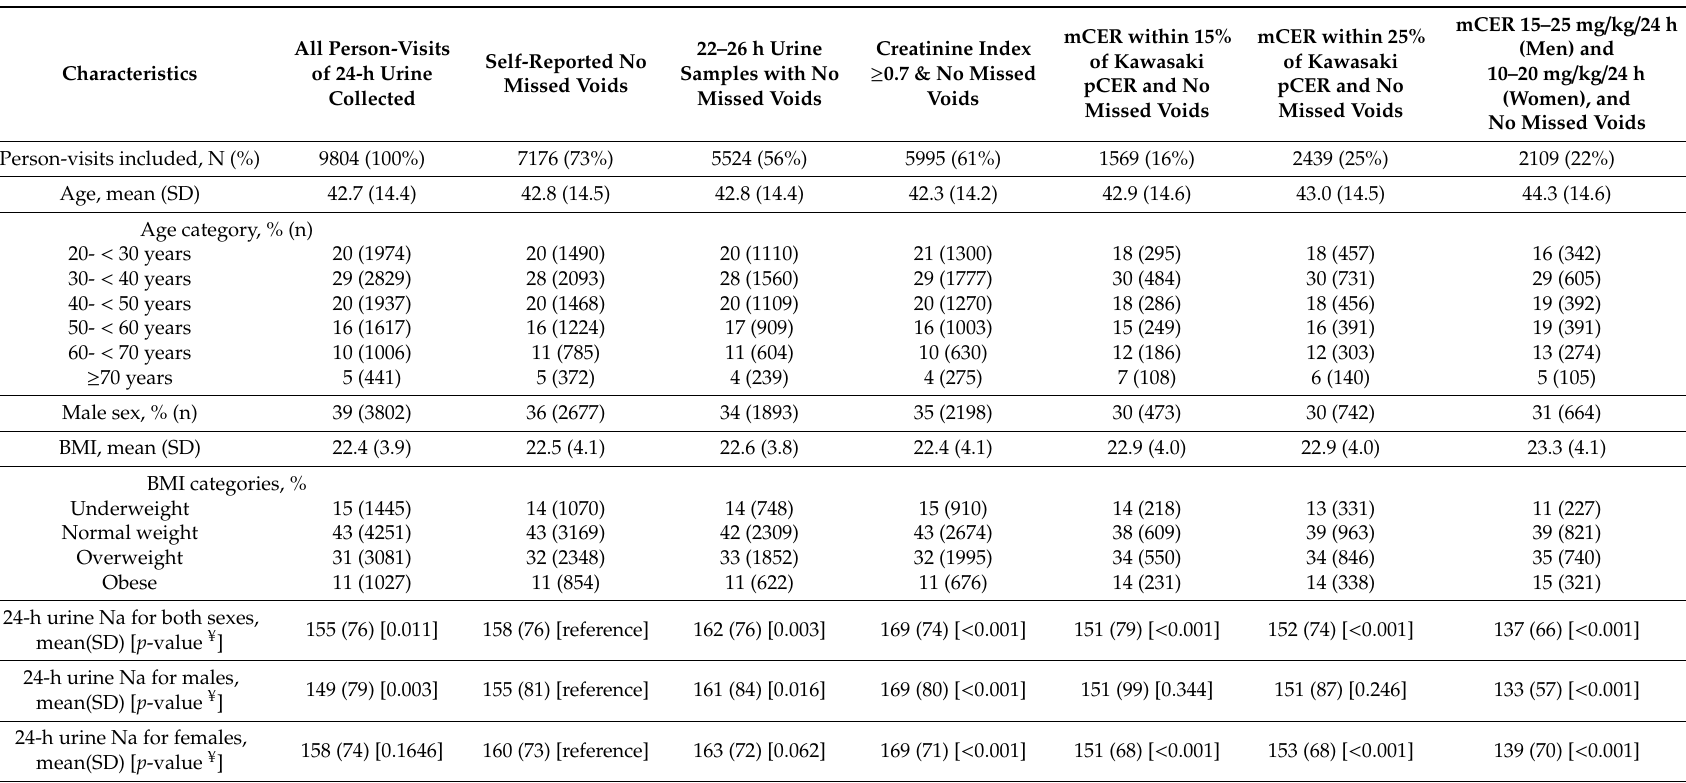
Table 1. Age, sex, and BMI distributions of person-visits in subsamples of the study population captured by di ff erent methods of evaluating the completeness of 24-h urine